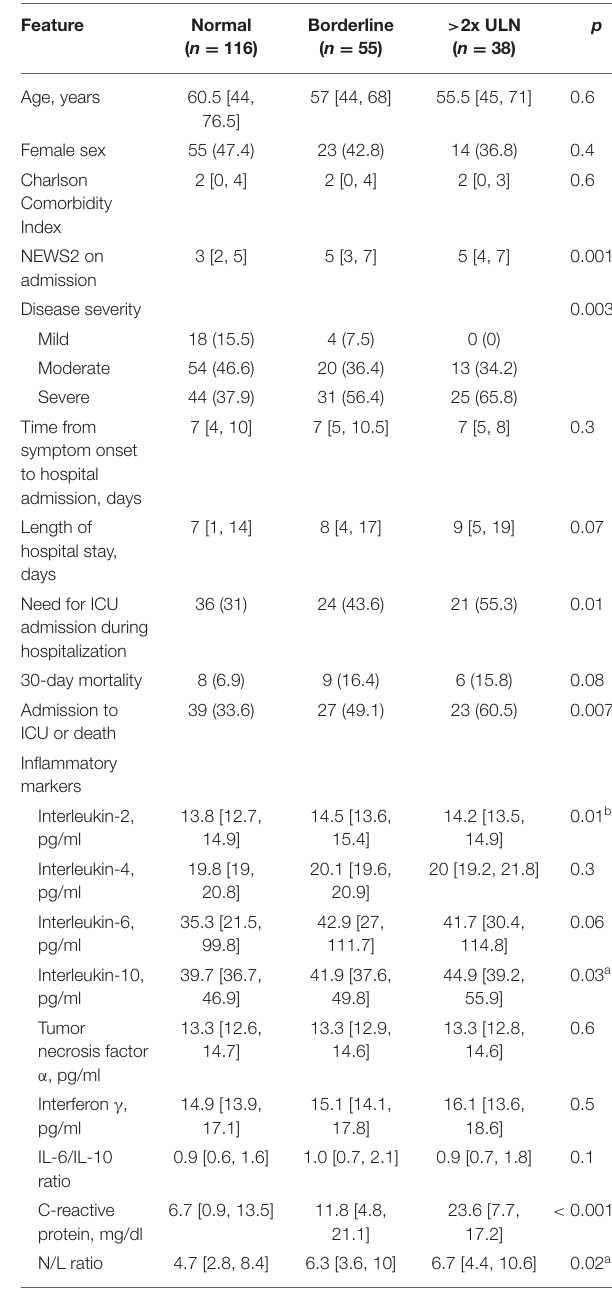
elevation of liver enzymes, which may occur through a direct target of SARS-CoV-2 or secondary to the systematic changes caused by viral infection (22). In this study, we showed that disease severity and inflammatory markers are associated with progressive elevations in liver transaminase levels in adult patients with COVID-19. Moreover, plasma levels of IL-2